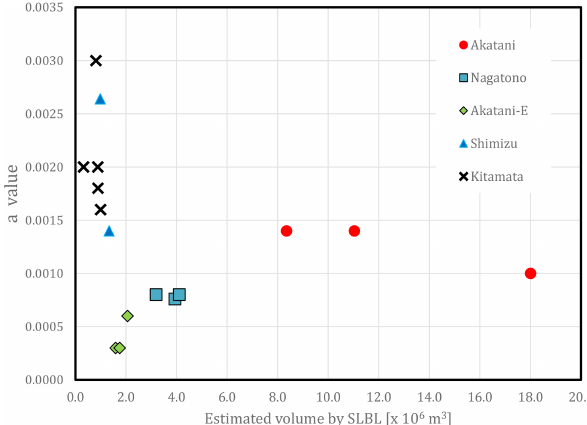
Figure 26. Values of a , the equivalent parabola term from Eq. (6), in relation to the volumes estimated for different scenarios of each